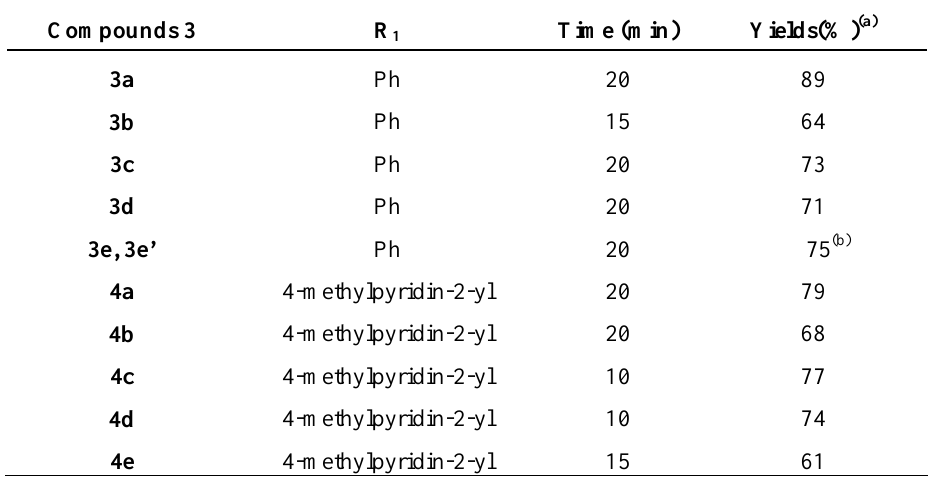
Table 1. Yields and reaction conditions used for the microwave syntheses of 3a-e and